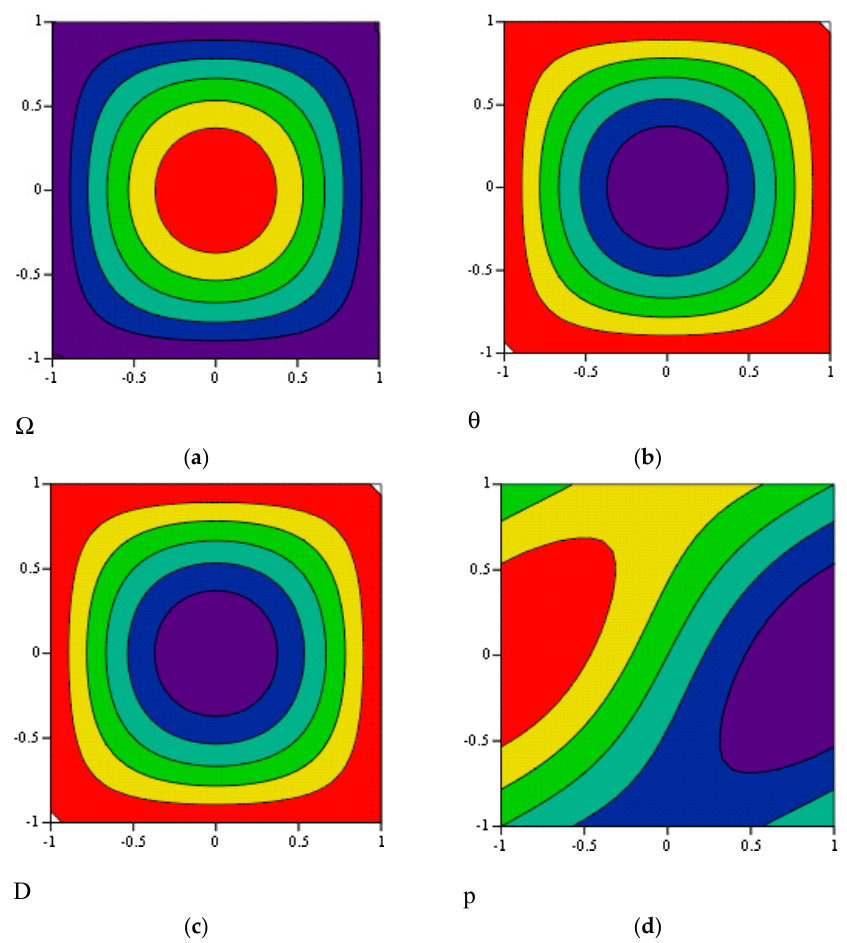
Figure 4. The calculated fields of vorticity ( a ), temperature ( b ), divergence ( c ), and pressure ( d ) in = upper part of the vortex cell (at 1 5 z .